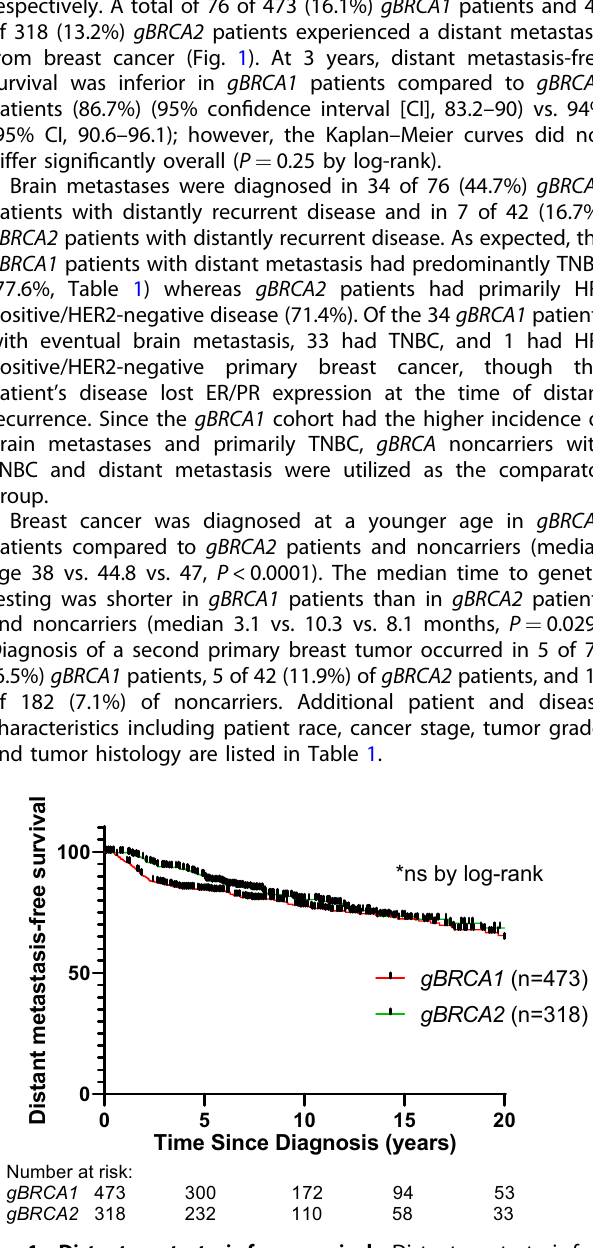
Fig. 1 Distant metastasis-free survival. Distant metastasis-free survival for patients diagnosed with stage I-III breast cancer by gBRCA